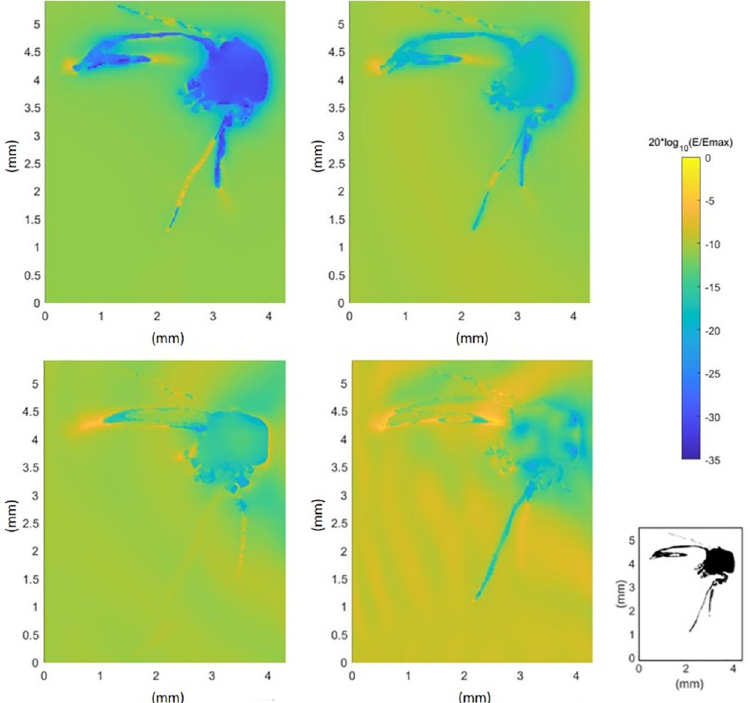
Fig 5. Normalized electric field strength in and around a mosquito. Electric field strength (dB) normalized to the maximal electric field strength of the simulation ( E max ) in the cross sections of mosquito M1 at 6 GHz (top left), 60 GHz (top right), 120 GHz (bottom left) and 240 GHz (bottom right). Configuration 1 (Fig 1) was used for all simulations. The bottom right panel shows a cross section of the